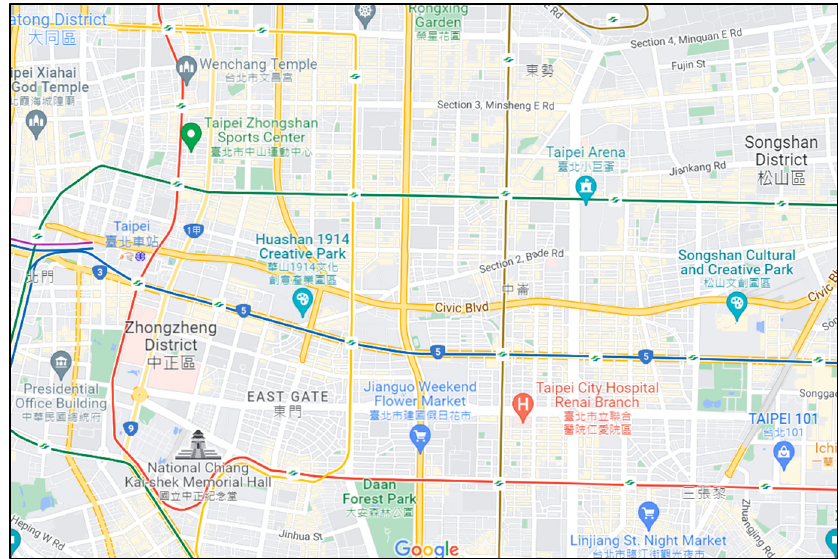
Figure 5. SD-QGrid experimental map.